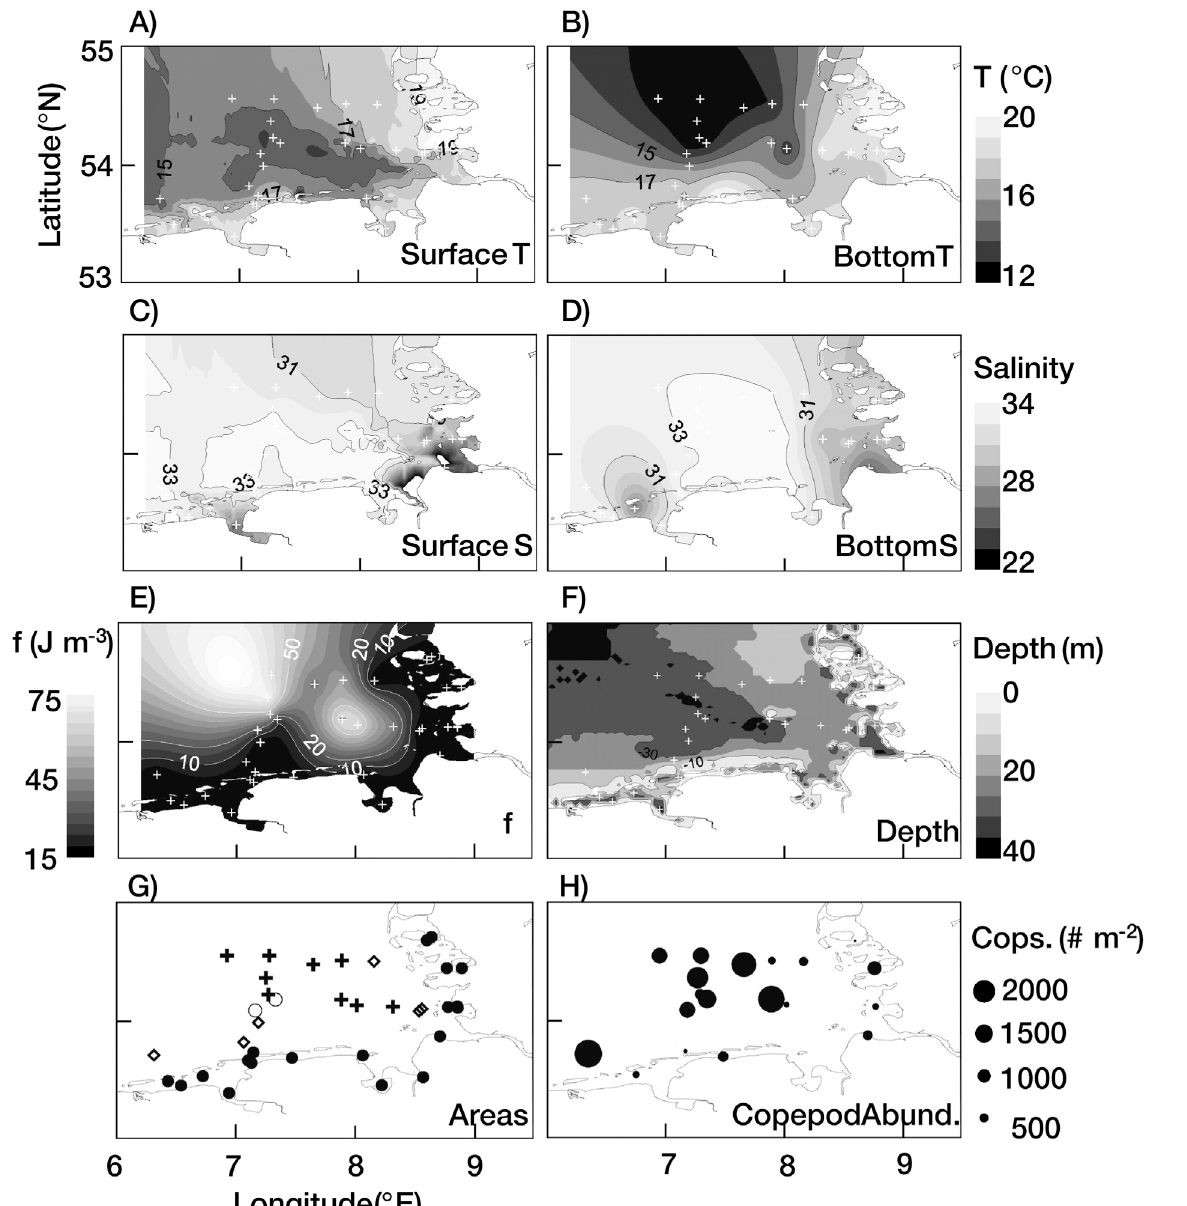
F IG . 2. – Hydrographic situation within the sampling region during June/July 2005. Panels A - F display surface (ST) and bottom (BT) temper- ature (C°), surface (SS) and bottom (BS) salinity (psu), stratification index ( f ) and depth (m), respectively. Note that within panel A-E, kriged values are shown. Panel G indicates the four station categories (nearshore/Wadden Sea [filled circles], well-mixed water masses [unfilled diamonds], tidal mixing front [unfilled circles] and stratified water masses [crosses]), and finally, the abundance of copepods (individuals m -2 ) captured using 500-µm Bongo gear is indicated in Panel H. Sampling locations are indicated by small white